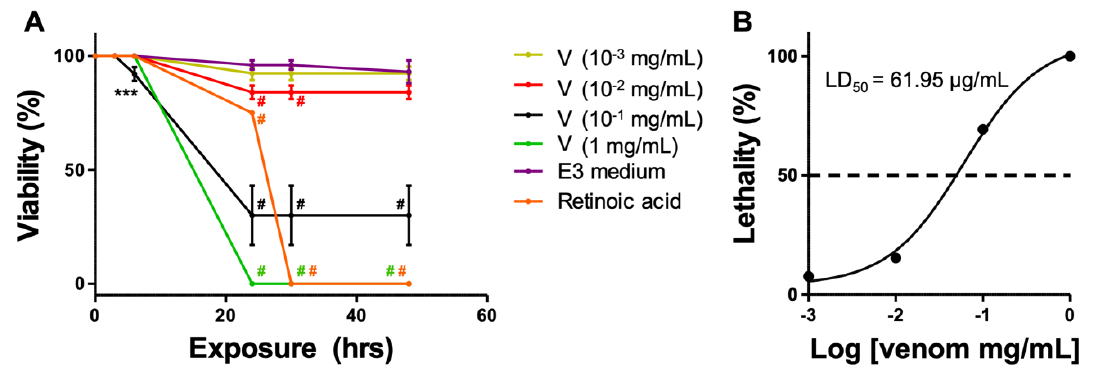
Figure 1. M. bornmuelleri ’s venom toxicity on zebrafish embryos . ( A ) Viability rates of zebrafish embryos exposed to different concentrations of the venom (V) in the early blastula stage (2 hpf). E3 medium was used as the negative control, while retinoic acid was used as the positive control. *** p ≤ 0.001 and # p ≤ 0.0001 compared to the negative control of each time point and color-coded for clarity. N = 13 for each venom condition, N = 30 for E3 condition, and N = 8 for retinoic acid condition. ( B ) Dose–response mortality curve of M. bornmuelleri ’s venom on zebrafish embryos after 24 hrs of exposure. The LD 50 value is indicated.